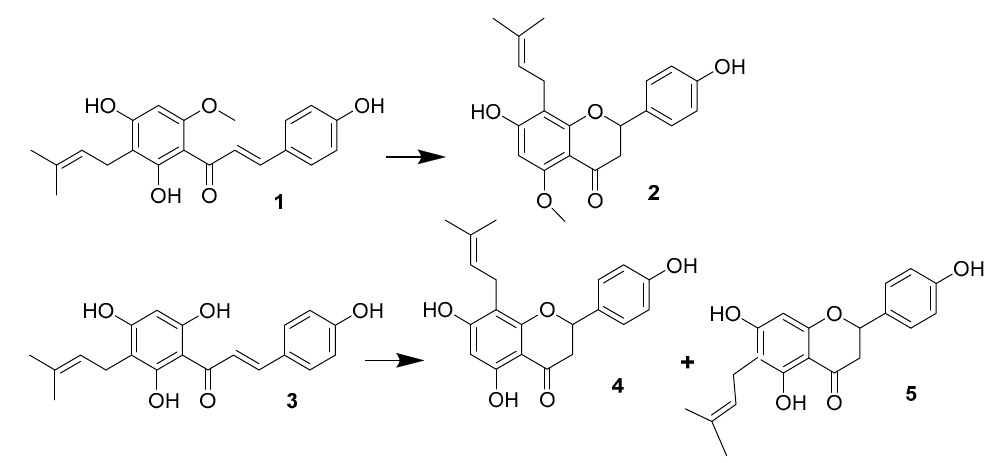
Figure 3. Paths of formation of IXN ( 2 ), 8-PN ( 4 ) and 6-PN ( 5 ) during wort boiling.